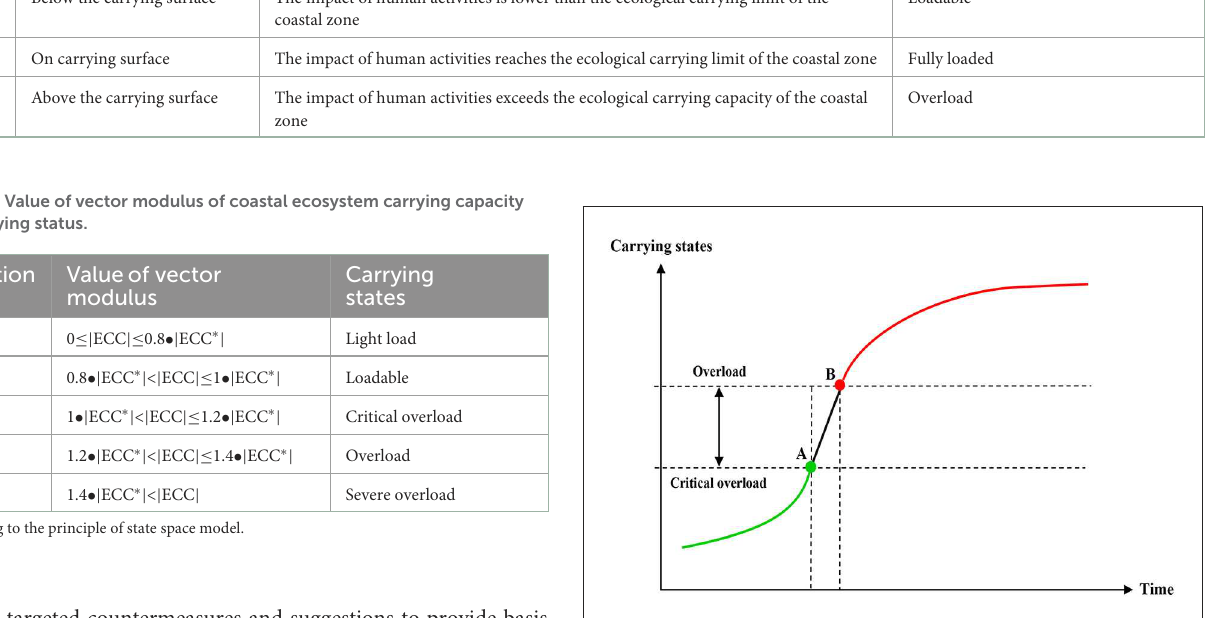
FIGURE3 Principle of ecosystem health early